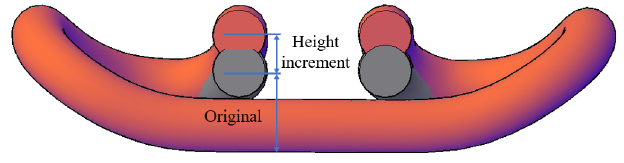
Figure 5. Perspective view of change in the height of the fastening spring end. Figure 6 plots the global response of the fastening force vs. the displacement for var- ious heights of the fastening spring end. Vertical displacement was applied to the torque location, and the displacement values corresponding to the rail fastening force (i.e., clamp- ing force to the rail) of 9 kN were applied to the finite element models. Figure 7a shows the maximum principal stresses during fastening in Step 1, varying the height of the fas- tening spring, while Figure 7b shows the range of maximum principal stresses due to the vertical deflection caused by train use. Steps 1 and 2 yielded the stress range shown in Figure 7b. It can be observed from the results that the variation of the spring end height has little effect on the stress conditions of the fastening spring. This might be due to the fact that the internal forces (i.e., shear force and bending moment) on the critical sections of stress concentration have little change for each model because the moment arm from the loading location to the critical sections remained unchanged. In other words, the fa- tigue performance of the fastening spring may not be significantly affected by the change in the end height. Figure 6. Fastening force vs. displacement diagram varying the spring end height difference. Figure 7. Stress variation with the height of spring end: ( a ) maximum principal stress; ( b ) maximum principal stress range. 3.2. Height of the Spring Arm The effect of the spring arm height on the fatigue performance of the fastening spring was investigated. Figure 8 shows the perspective view of the change in the spring arm height. Four di ff erent cases with spring arm height increments of − 20%, − 10%, +10%, and +20% were compared with the original fastening spring (+0%). Figure 9 plots the global